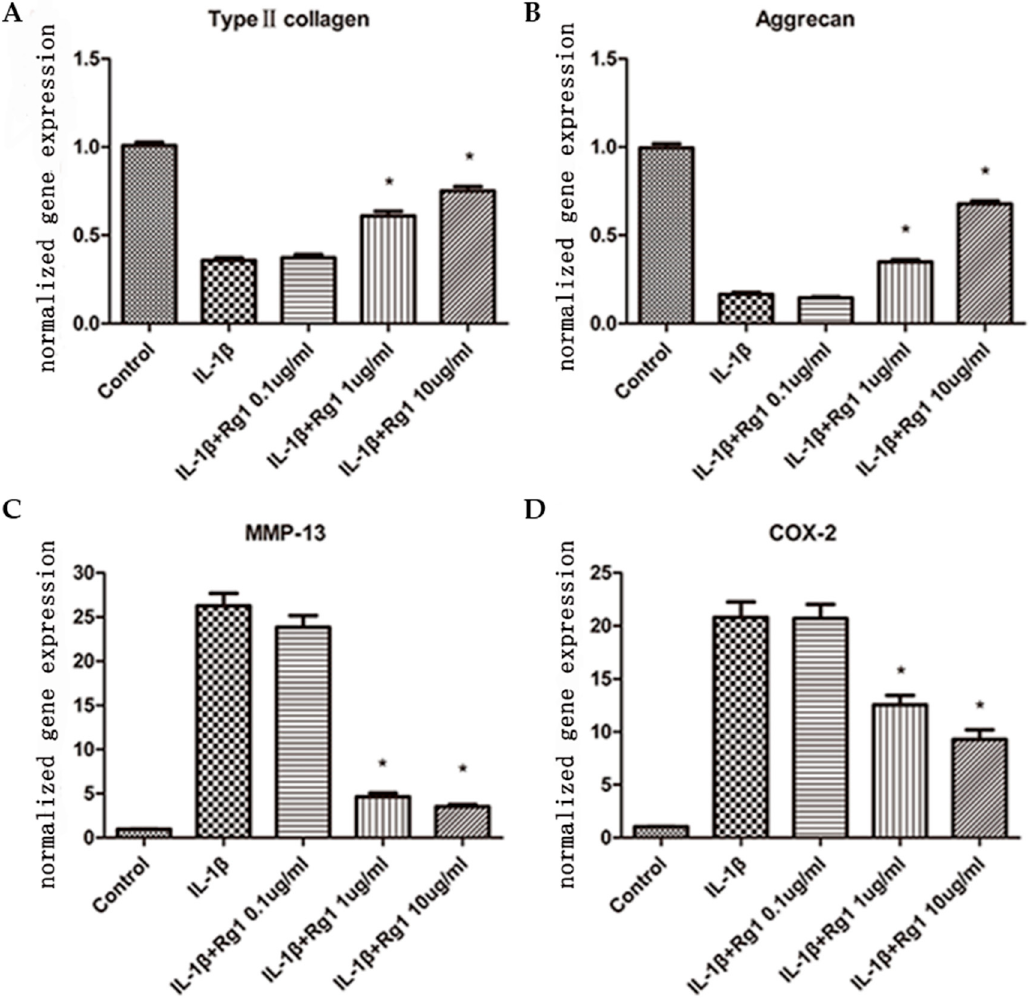
Figure 1. Effect of Ginsenoside Rg1 (Rg1) on gene expression levels of extracellular matrix and inflammatory mediators after induction by Interleukin (IL)-1 β . Human osteoarthritis (OA) chondrocytes were treated with the medium (control group), and IL-1 β (10 ng/mL) alone or in combination with Rg1 (0.1, 1, or 10 µ g/mL). Gene expression levels of type II collagen ( A ), aggrecan ( B ), matrix metalloproteinase (MMP)-13 ( C ) and cyclooxygenase-2 (COX-2) ( D ) were determined by quantitative real-time PCR, normalized to glyceraldehyde-3-phosphatedehydrogenase (GADPH) and expressed as means ± Standard Error of Mean (SEM) of four independent experiments. * p < 0.05 compared with cells treated with IL-1 β